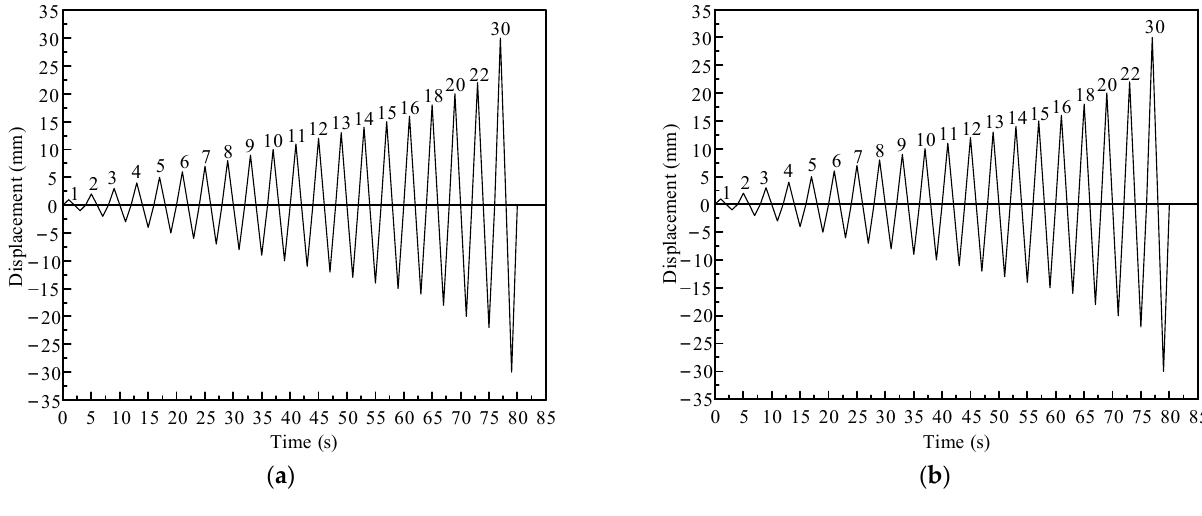
Figure 7. Specimen loading system. ( a ) L-shaped specimen; ( b ) T-shaped specimen.